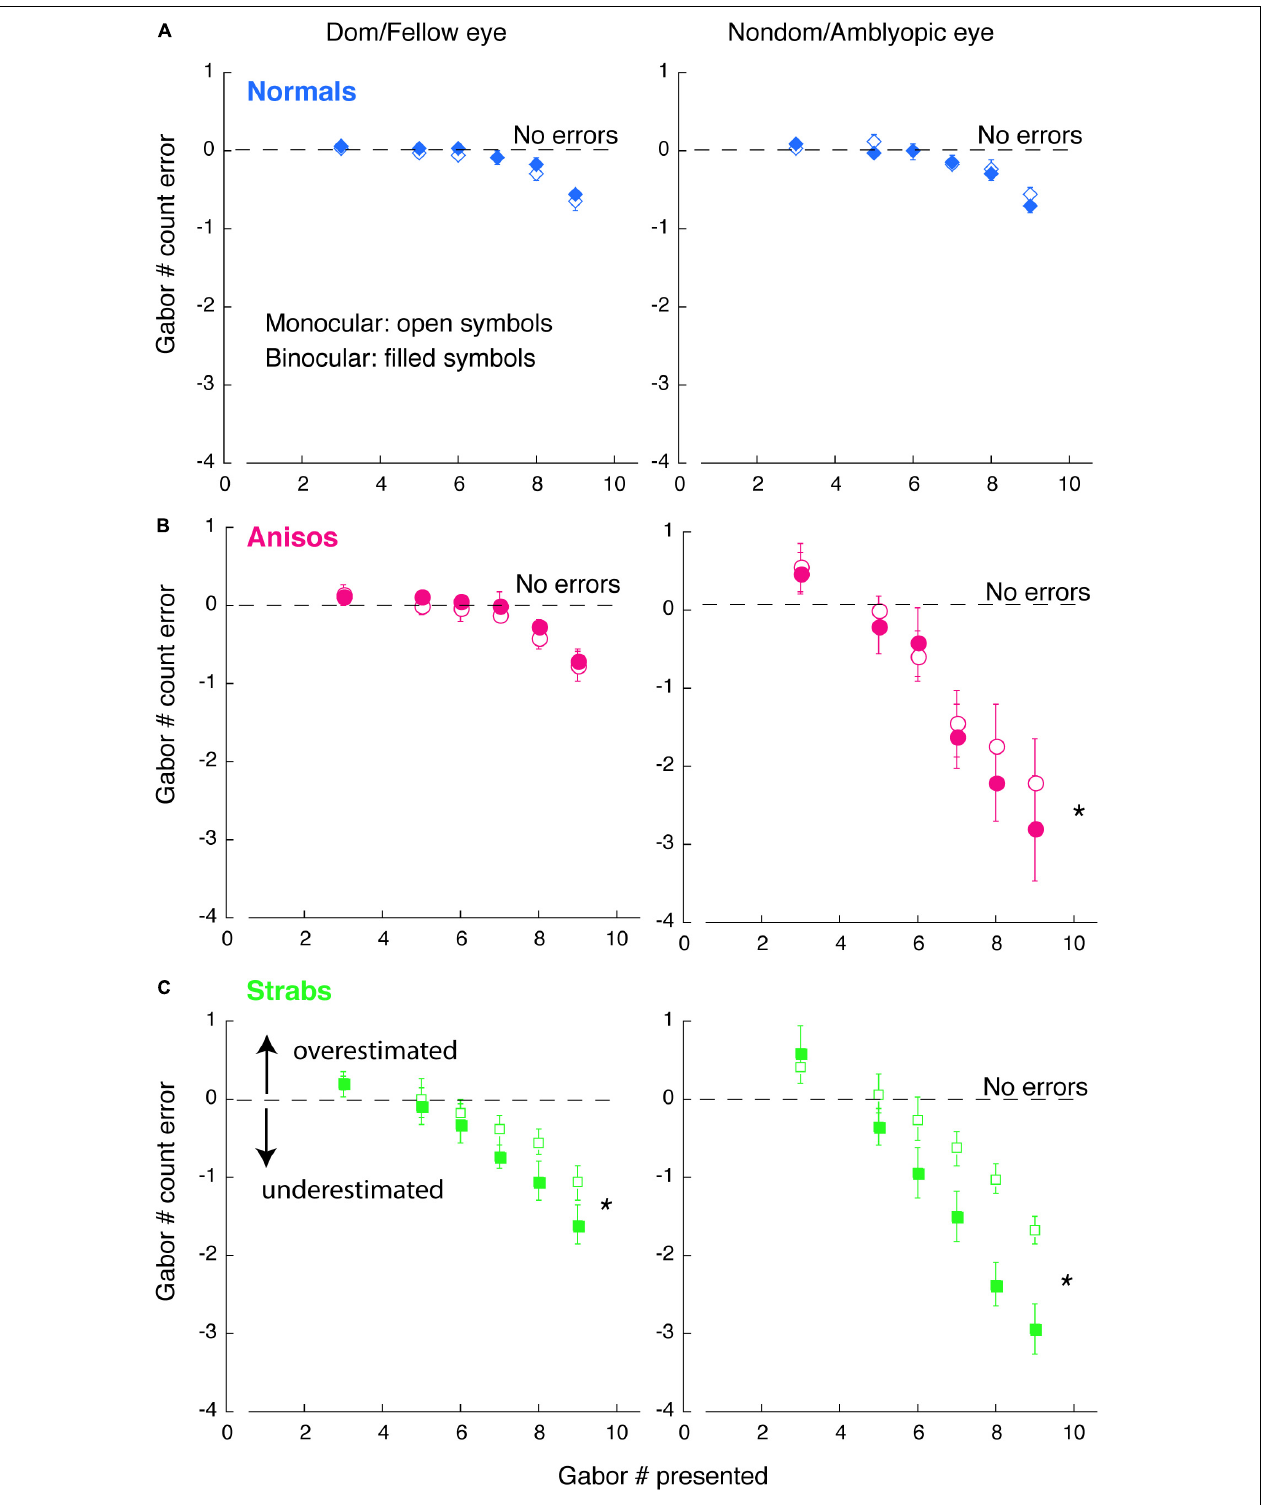
FIGURE 4 | Comparison of counting errors between monocular and binocular viewing in each eye of (A) Normals, (B) Anisos, and (C) Strabs. Left column: Dom/Fellow eye; Right column: Nondom/Amblyopic eye. Open symbols: monocular viewing; Filled symbols: binocular viewing. The horizontal dashed lines indicate no counting errors. Data below the dashed lines indicate underestimates of the number of Gabors; and data above the dashed lines indicate overestimates of the number of Gabors. * denotes p < 0.025 (Bonferroni correction).